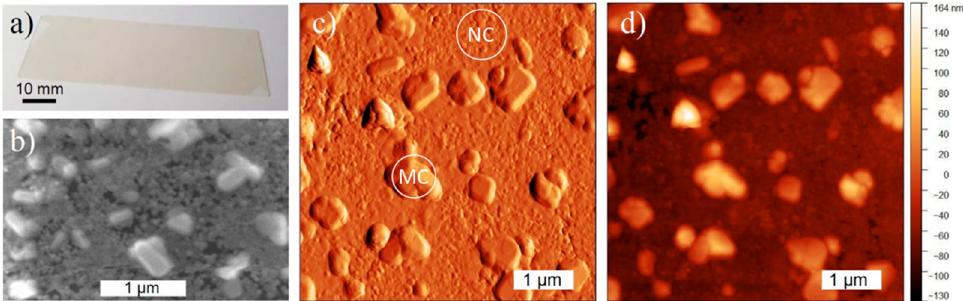
Figure 1. ( a ) Typical photograph of a 70 nm thick CsPbCl 3 sample; ( b ) SEM micrograph of sample A. ( c , d ) AFM amplitude and topography maps of a 5 × 5 µm 2 area of sample A. The circles with